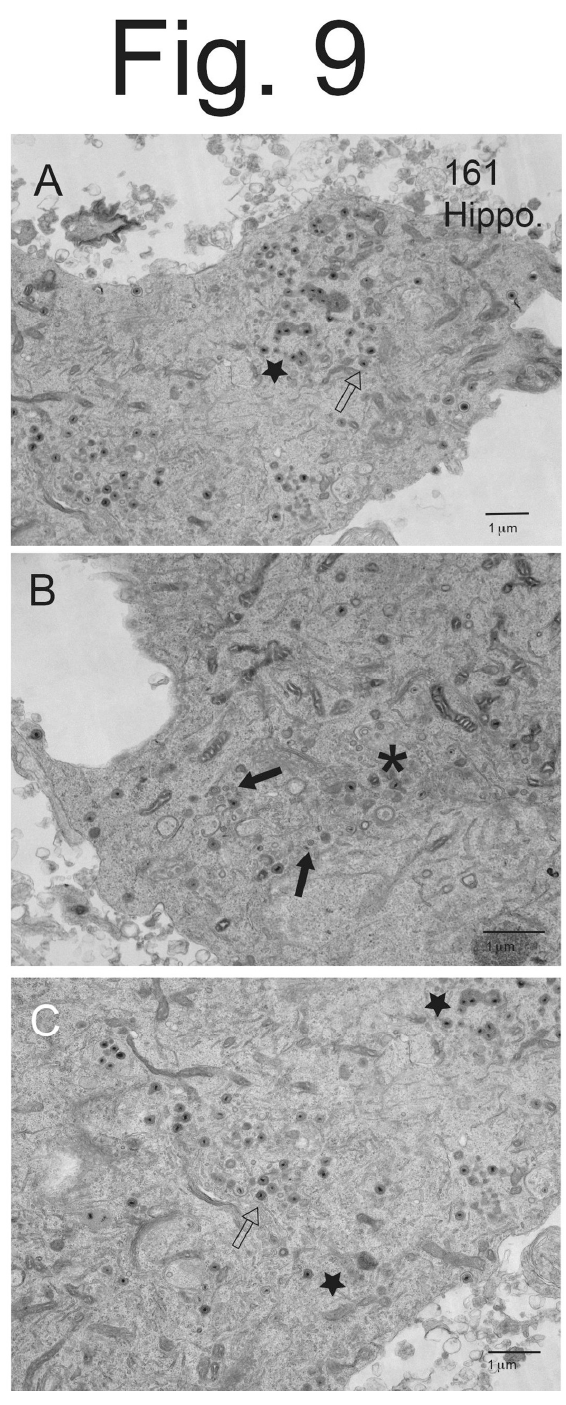
Figure 9. EM images of hippocampal neurons infected with PRV 161. Hippocampal neurons on Thermanox slides were infected with PRV 161 for 10–12 h then processed for EM. Panel ( A ) shows a neuron with few cell surface particles and large numbers of cytoplasmic enveloped particles (empty arrow), as well as enveloped particles that were misassembled with more than a single capsid in a vesicle and often immersed in electron-dense material. * Panel ( B ) shows a region of cytoplasm with numerous unenveloped capsids (filled arrows). There were also several partially enveloped capsids (asterisk). Panel ( C ) shows a neuron with numerous cytoplasmic enveloped virions that appeared normal (empty arrow) and others that showed evidence of electron-dense material at one pole or several capsids in a single vesicle (stars). * Star in Panel ( A